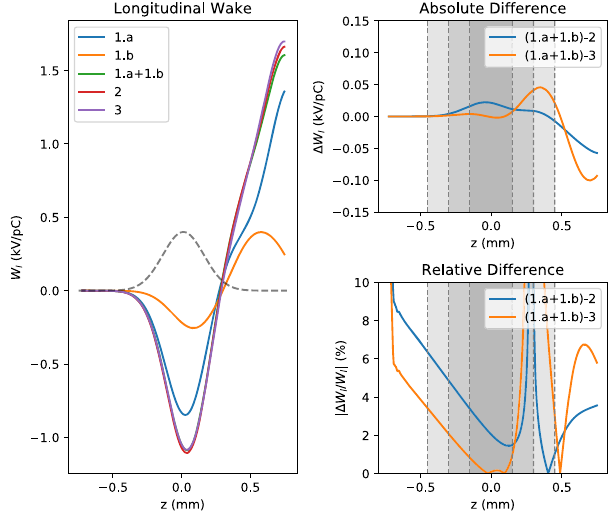
FIG. 13. Comparison of the wakefield obtained using the geometries illustrated in Fig. 11. l t ¼ 953 μ m, which is the value determined by the optimization scan shown in Fig. 12. The shaded areas correspond to the 6 σ , 4 σ and 2 σ parts of the drive bunch. The legends refer to the notation established in Fig.